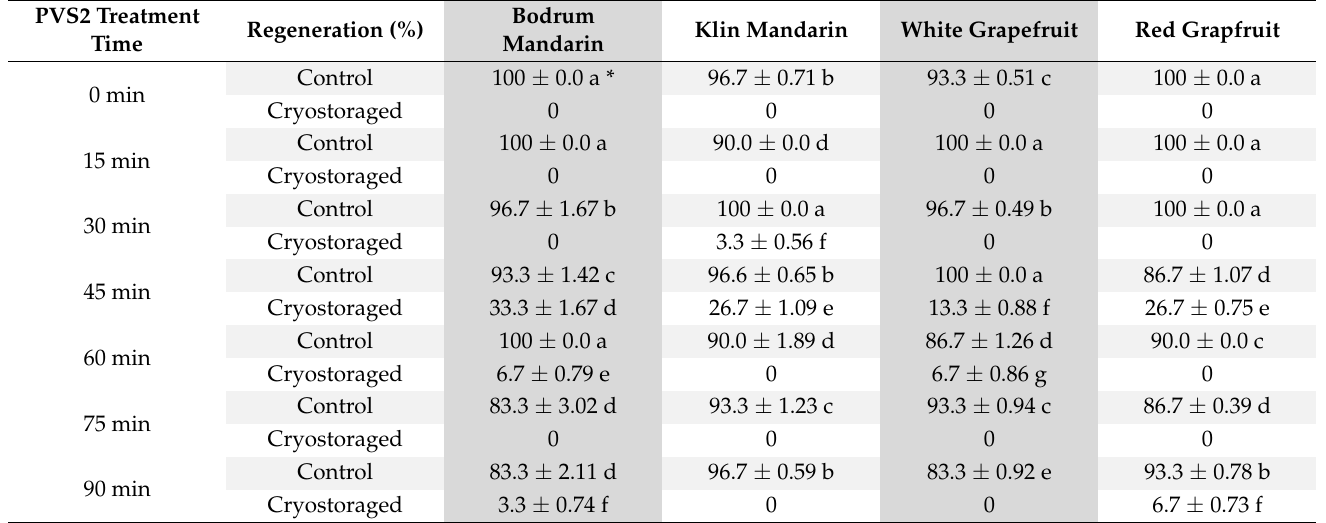
Table 5. The shoot tip regeneration of four different Citrus spp. cultivars tested in different PVS2 treatment times. After PVS2 treatment, the shoot tips were incubated in regeneration medium for the first 24 h, and then they transferred to WPM medium supplemented with 1 mg.L − 1 BAP, 10 mg.L −